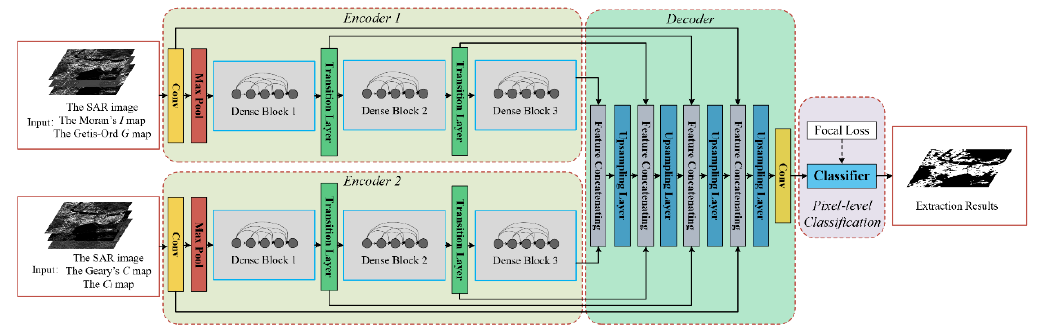
Figure 4. Structure of the proposed PSDNet model.